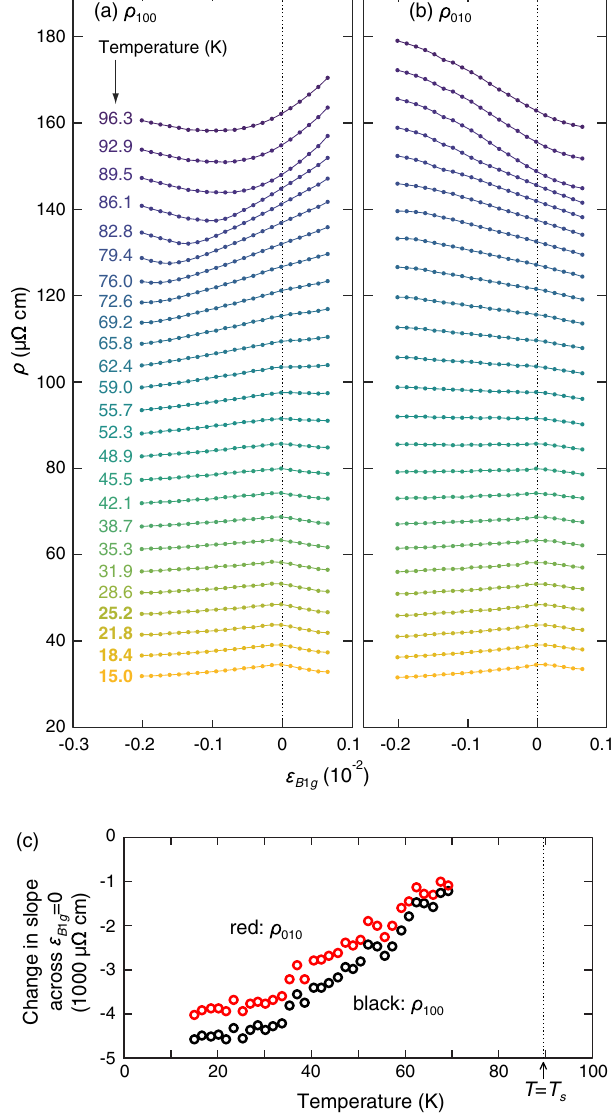
FIG. 11. (a),(b) Temperature-ramp data from sample C. Panel (a) shows ρ 100 and (b) ρ 010 . (c) Change in slope d ρ =d ε ε ¼ 0 . This quantity is proportional to the twin boundary B 1 g contribution to sample resistivity at ε